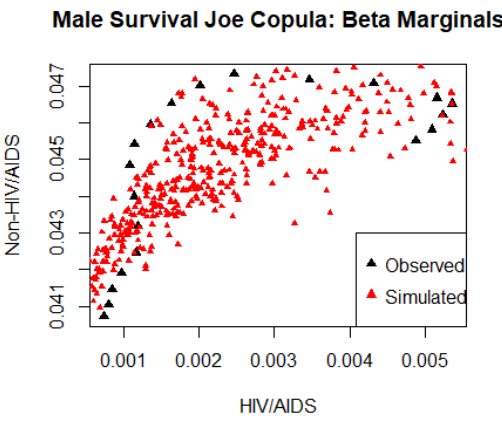
Figure 11. Beta marginal distribution for males.